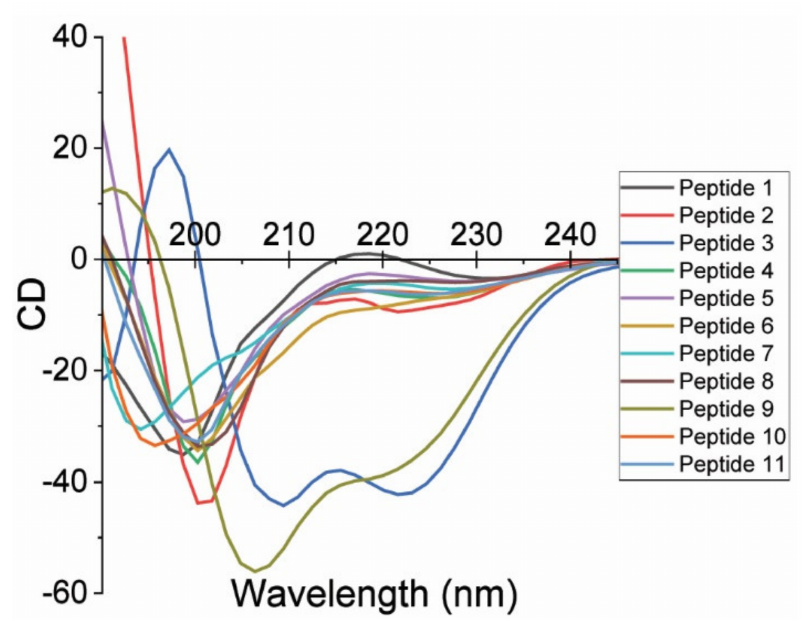
Figure 2. Circular dichroism measurements for eleven synthetic peptides in PBS-T (pH